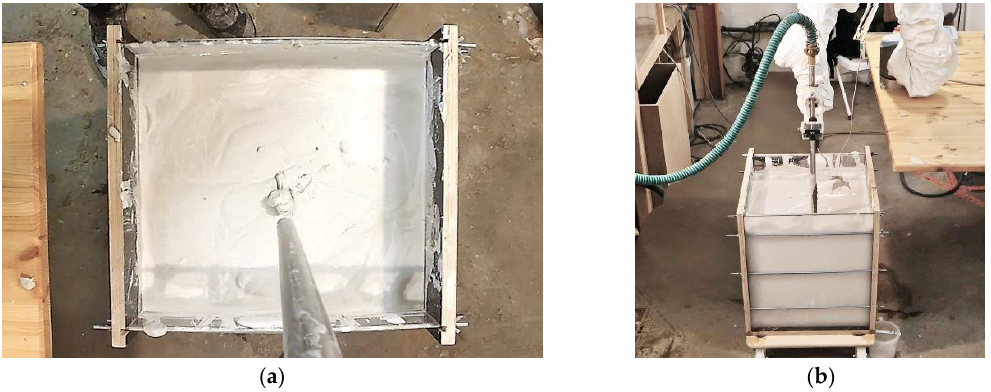
Figure 9. Printing process in the limestone-sand suspension: (a) closeup; (b) general setup with formwork placed on the ground.